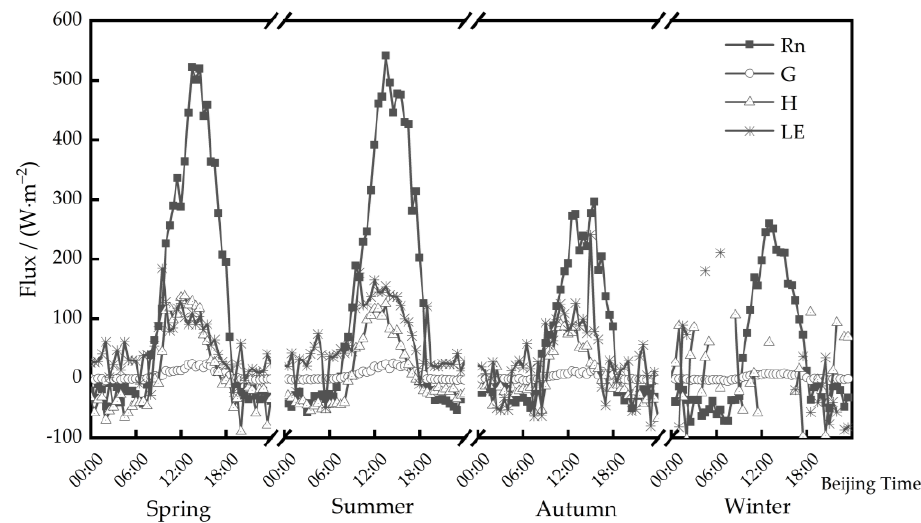
Figure 6. Average daily variation of each component of surface balance in each season.